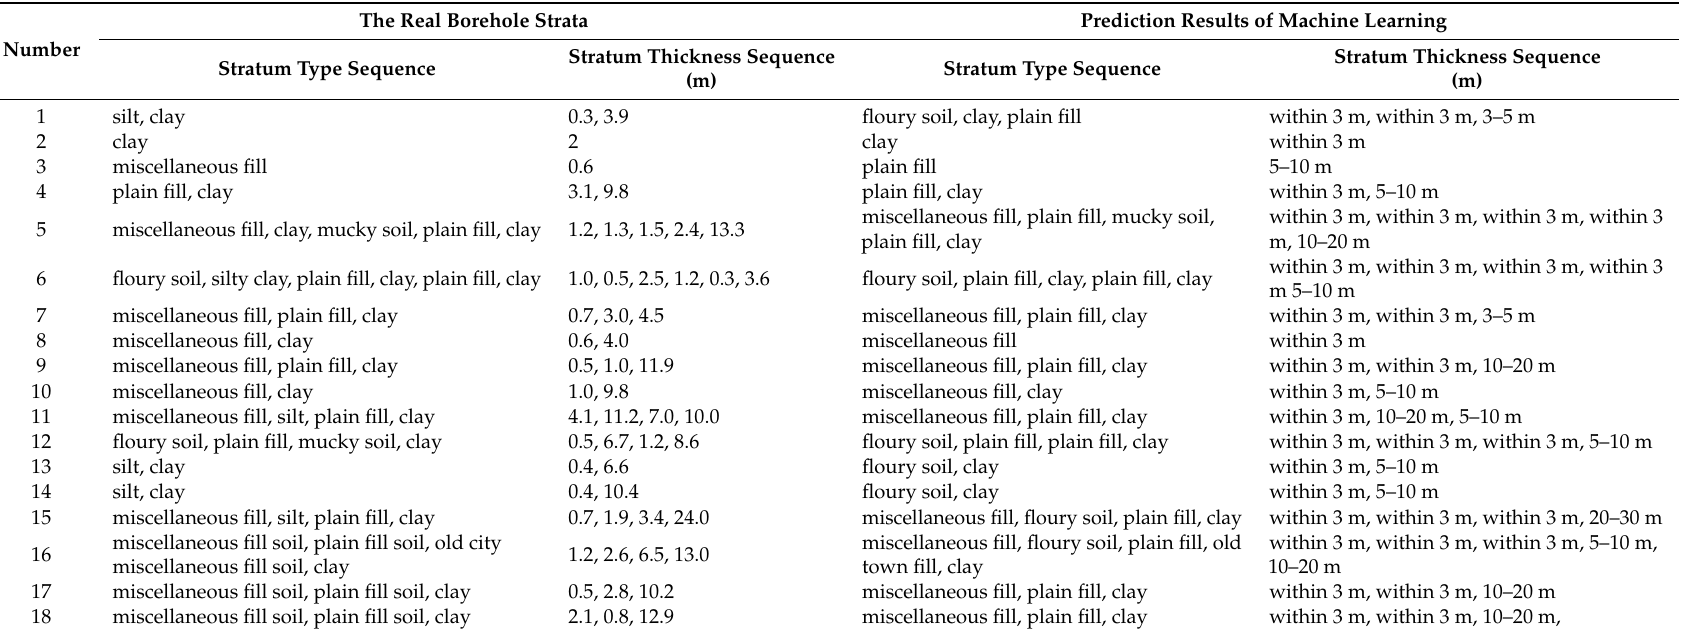
Table 8. Comparison of the real borehole stratum and machine learning prediction